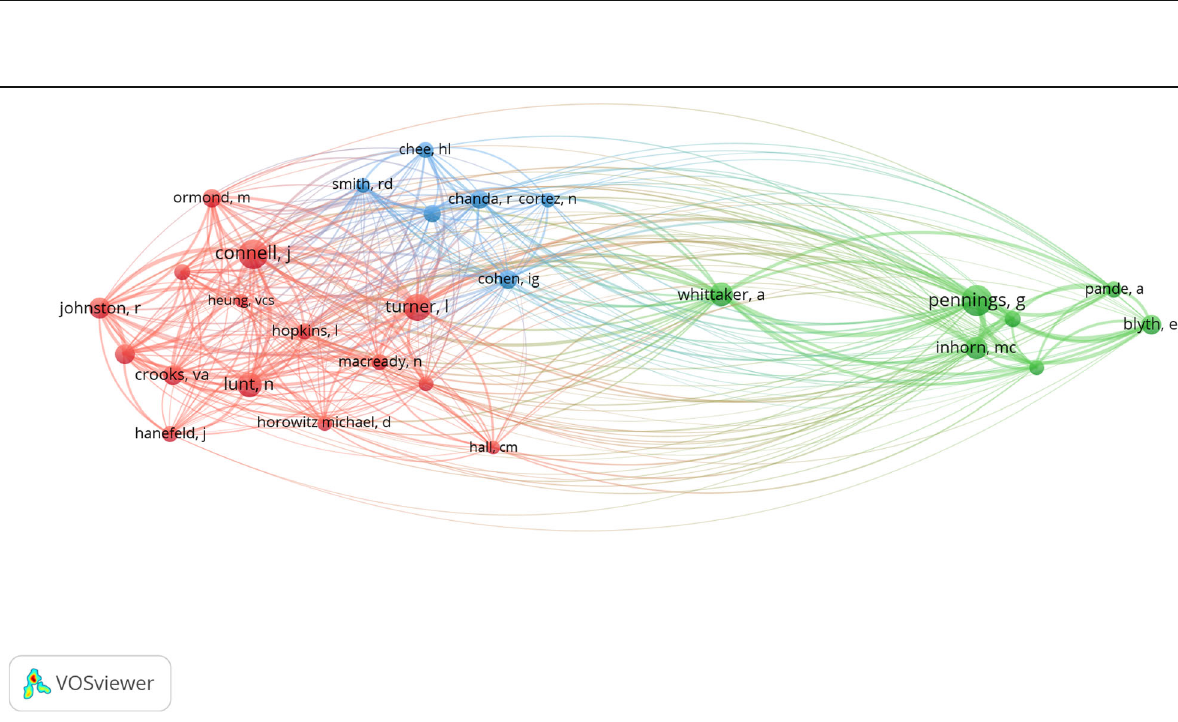
Fig. 9 Co-citation network of scholars with policy-related publications on medical tourism. Note: The figure shows how frequently scholars (with at least 20 citations) are cited together in publications. Nodes depict authors and their linkages convey co-citation relationships. Larger nodes indicate authors with more citations. Link strengths indicate the frequency with which they are co-cited. Scholars who are co-cited often are clustered together in nodes of the same